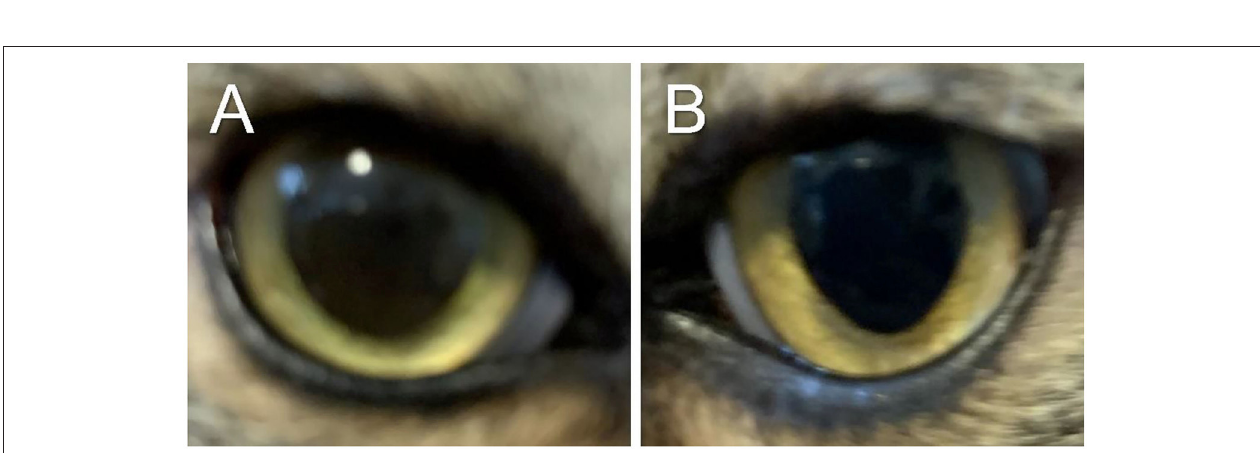
FIGURE 2 | Cytological specimen of the left corneal surface (Wright Giemsa stain) highlighting a mixed, predominantly eosinophilic inflammation (black arrowheads) with few mast cells and lymphocytes. Bar = 40 µ m (top right insert) or 100 µ m (background image).